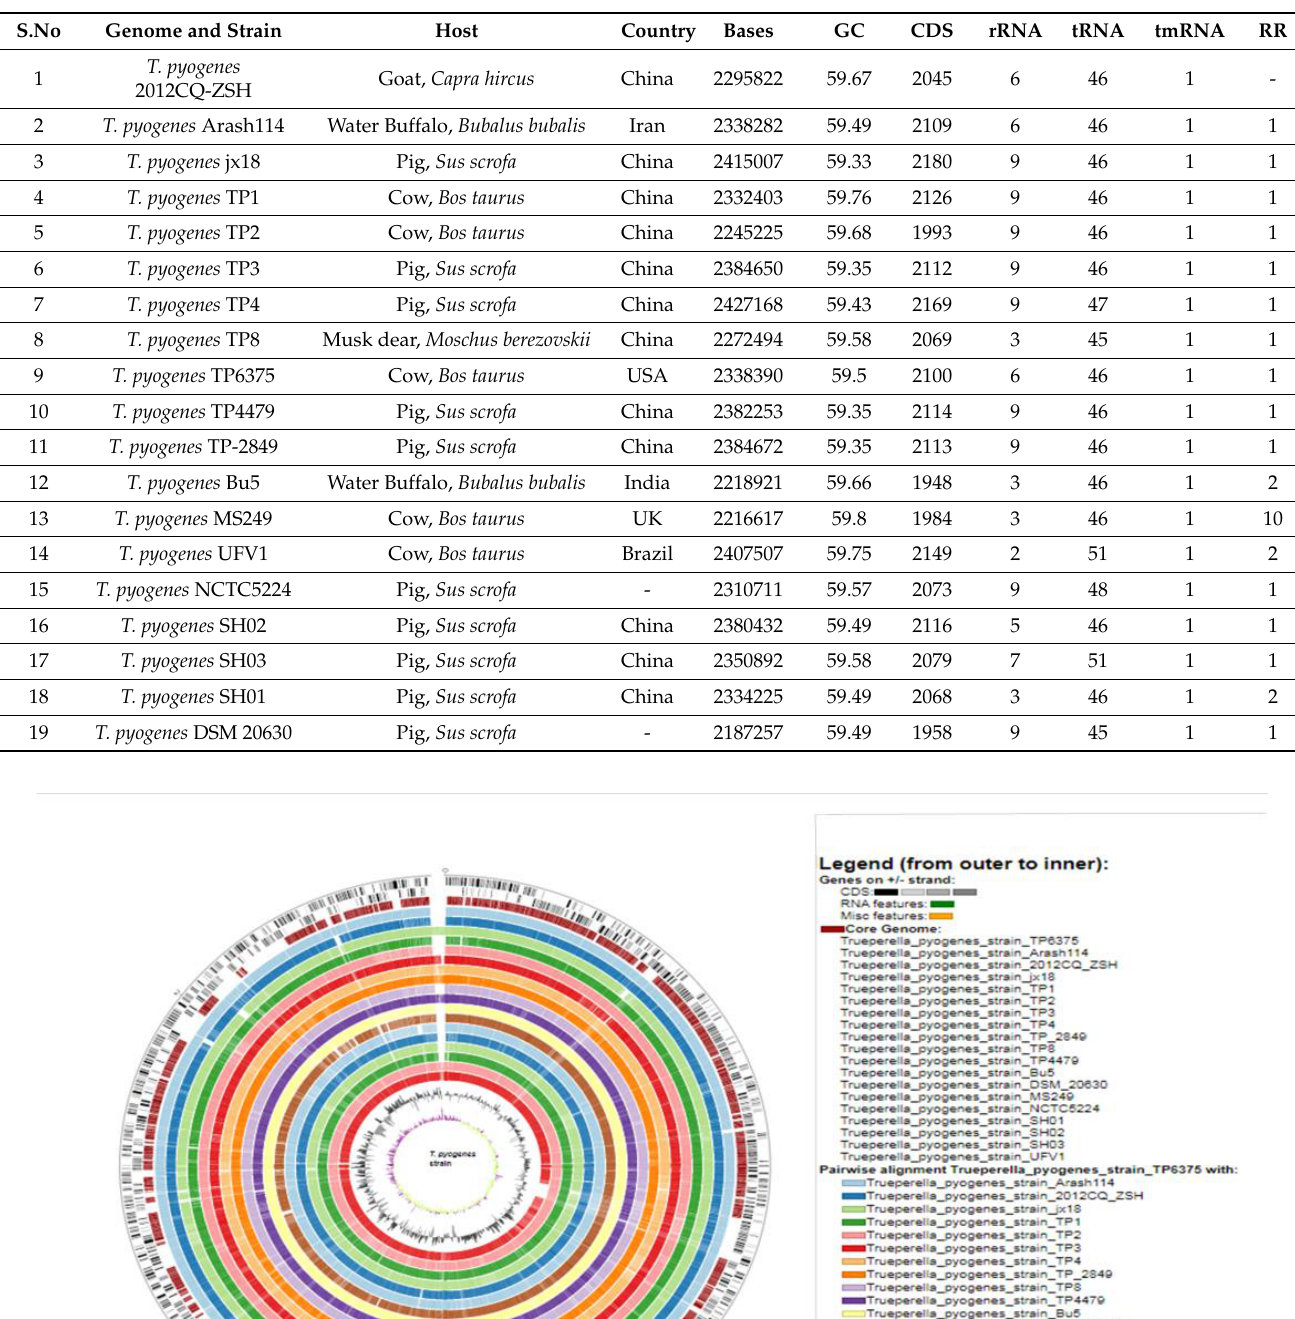
Table 1. Basic genomic features of the investigated T. pyogenes genomes such as isolation country, bases, number of CDS, rRNA, tRNA, tmRNA, and repeat regions.